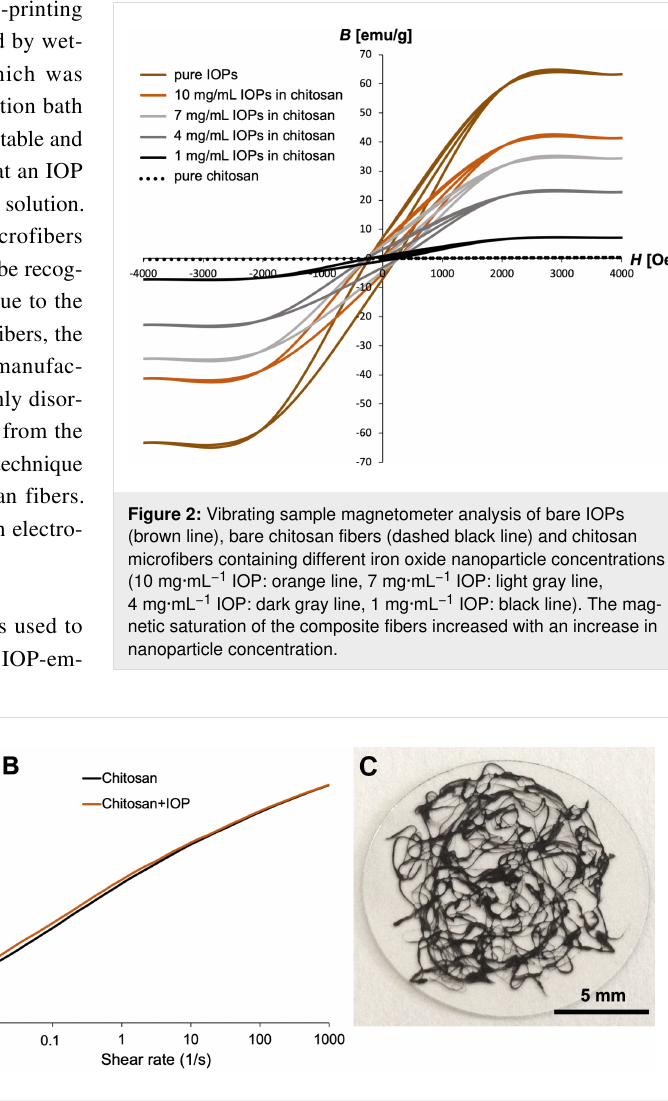
Figure 1: (A, B) Shear viscosity and shear stress of bare chitosan solutions (black lines) and chitosan solutions containing IOPs (orange lines). The precursor solution consisted of 30 mg·mL − 1 chitosan and 10 mg·mL − 1 IOPs. (C) Chitosan–IOP microfibers on a glass slide obtained by wet-spinning followed by coagulation in ethanol.